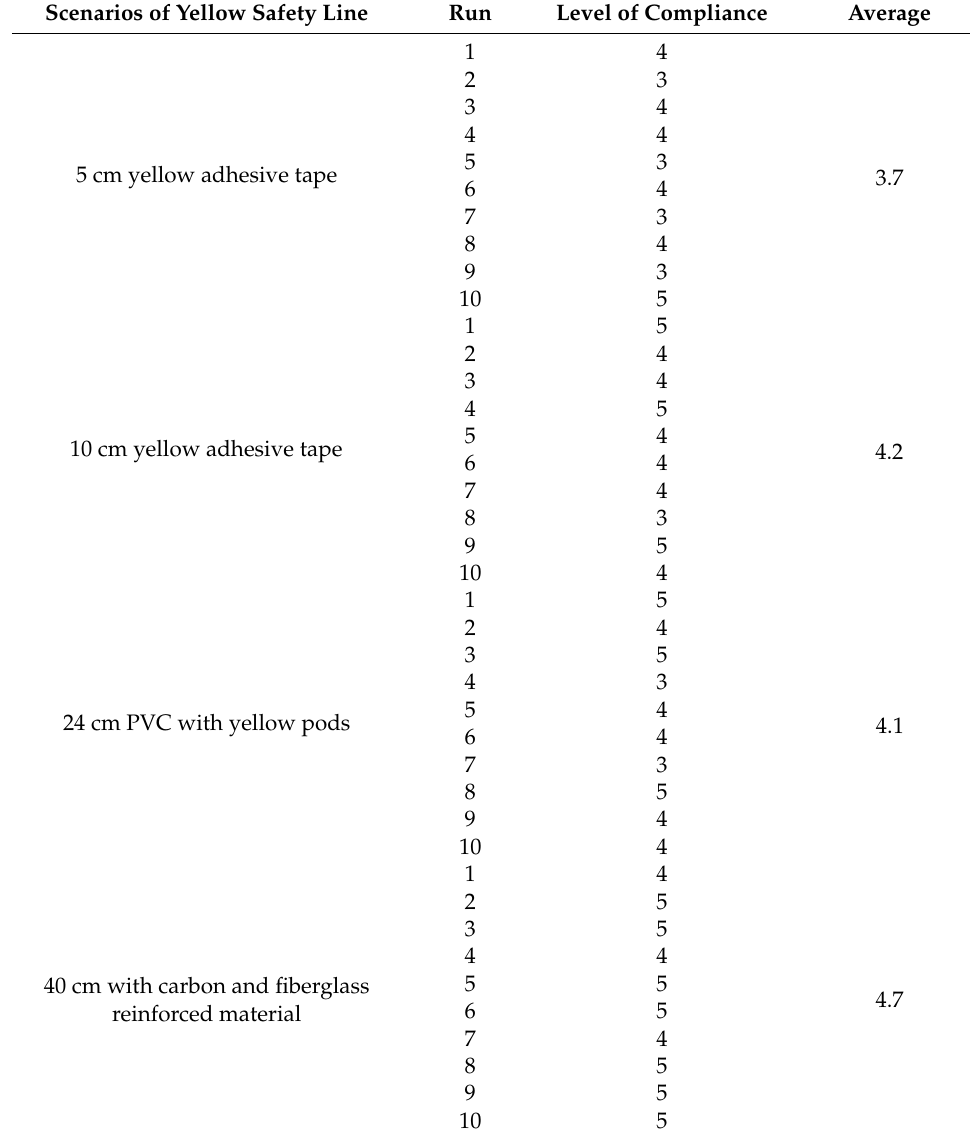
Table 3. Experimental evaluation method of the level of compliance for each scenario of the yellow safety